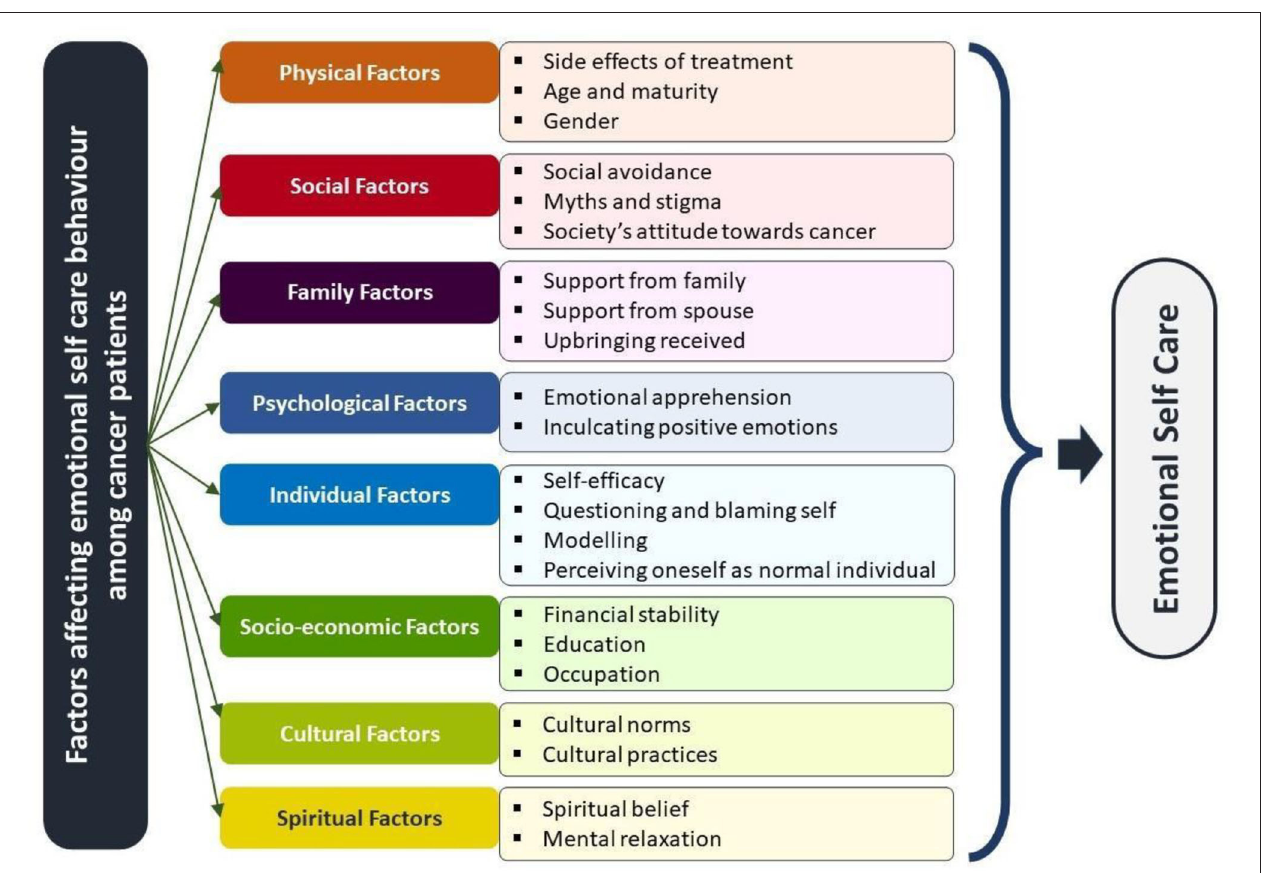
FIGURE 1 | Explored factors that influence emotional self-care among cancer